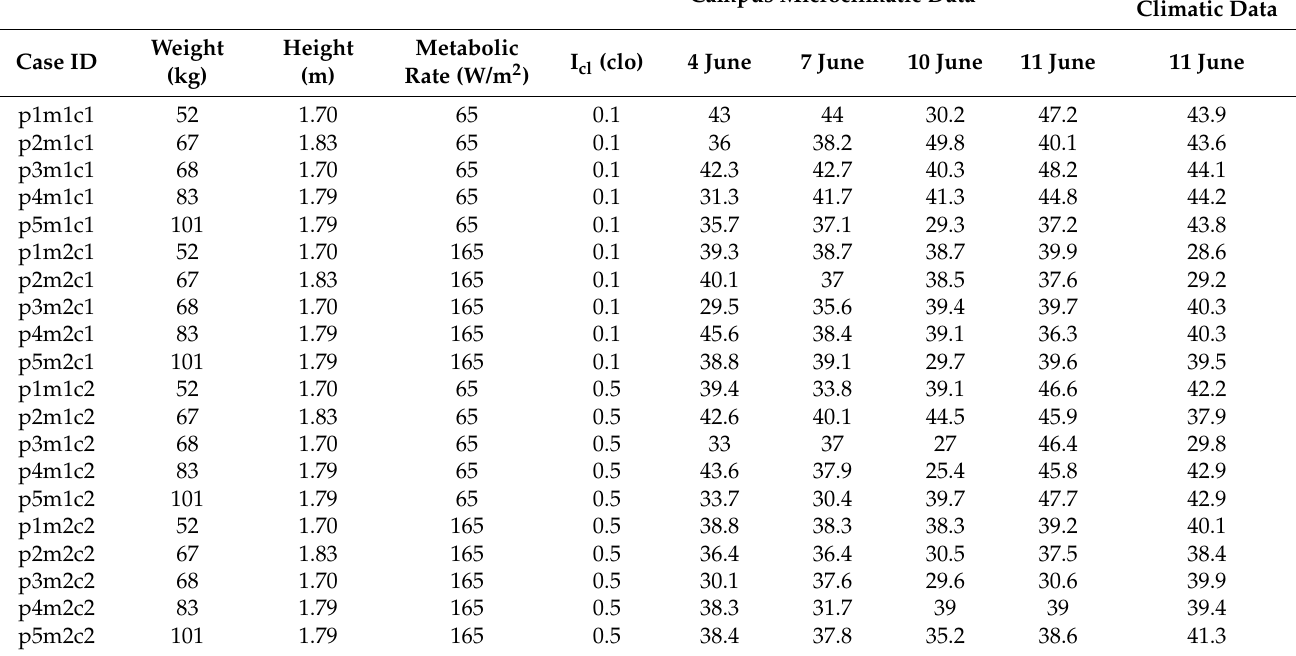
Table 7. Definition of the cases study considered for the calculation of outdoor thermal comfort using the PET metric under preferred weather conditions, the level of activity, and I cl